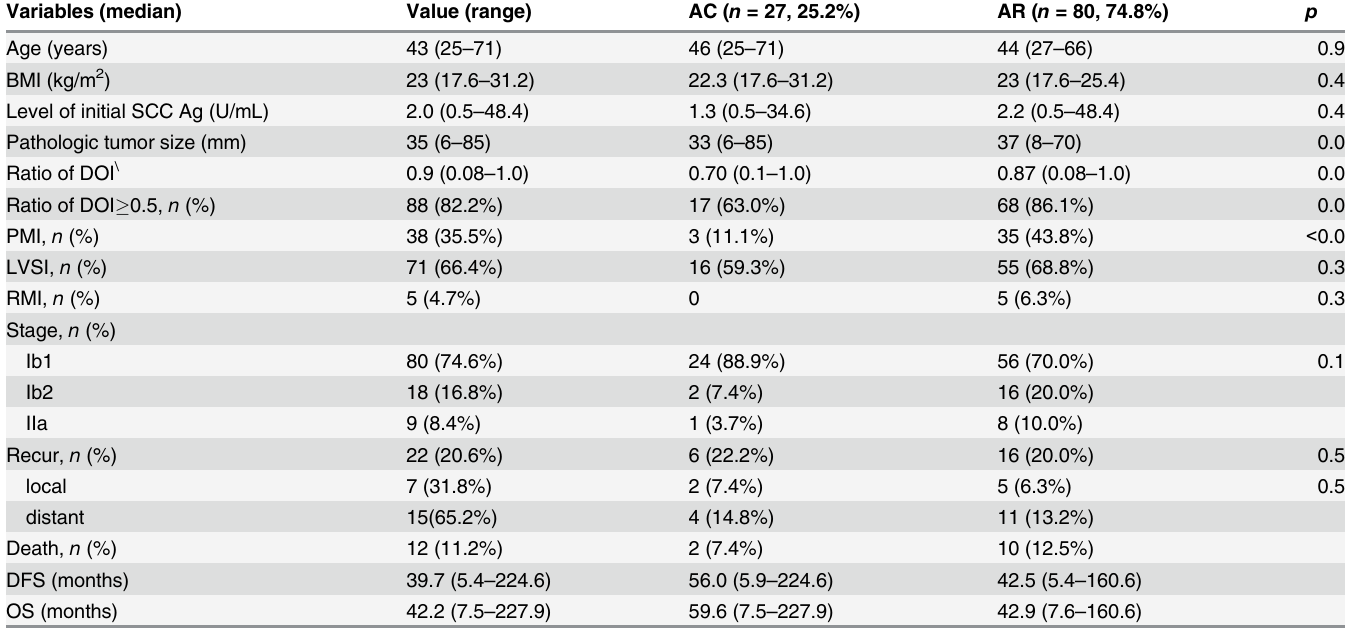
Table 3. Baseline characteristics and comparison of patients in the AC and AR treatment arms from the nodal metastasis subgroup ( n = 107). Variables